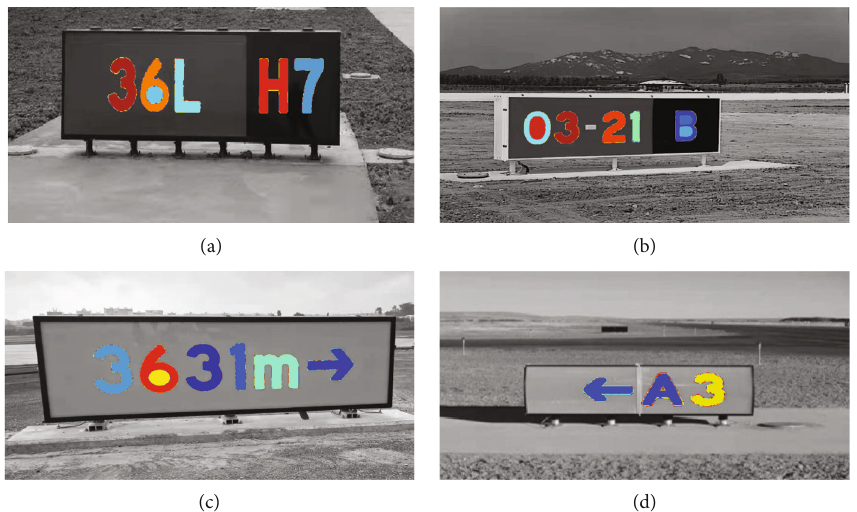
Figure 4: The content of the signs after removing the nontext areas of the